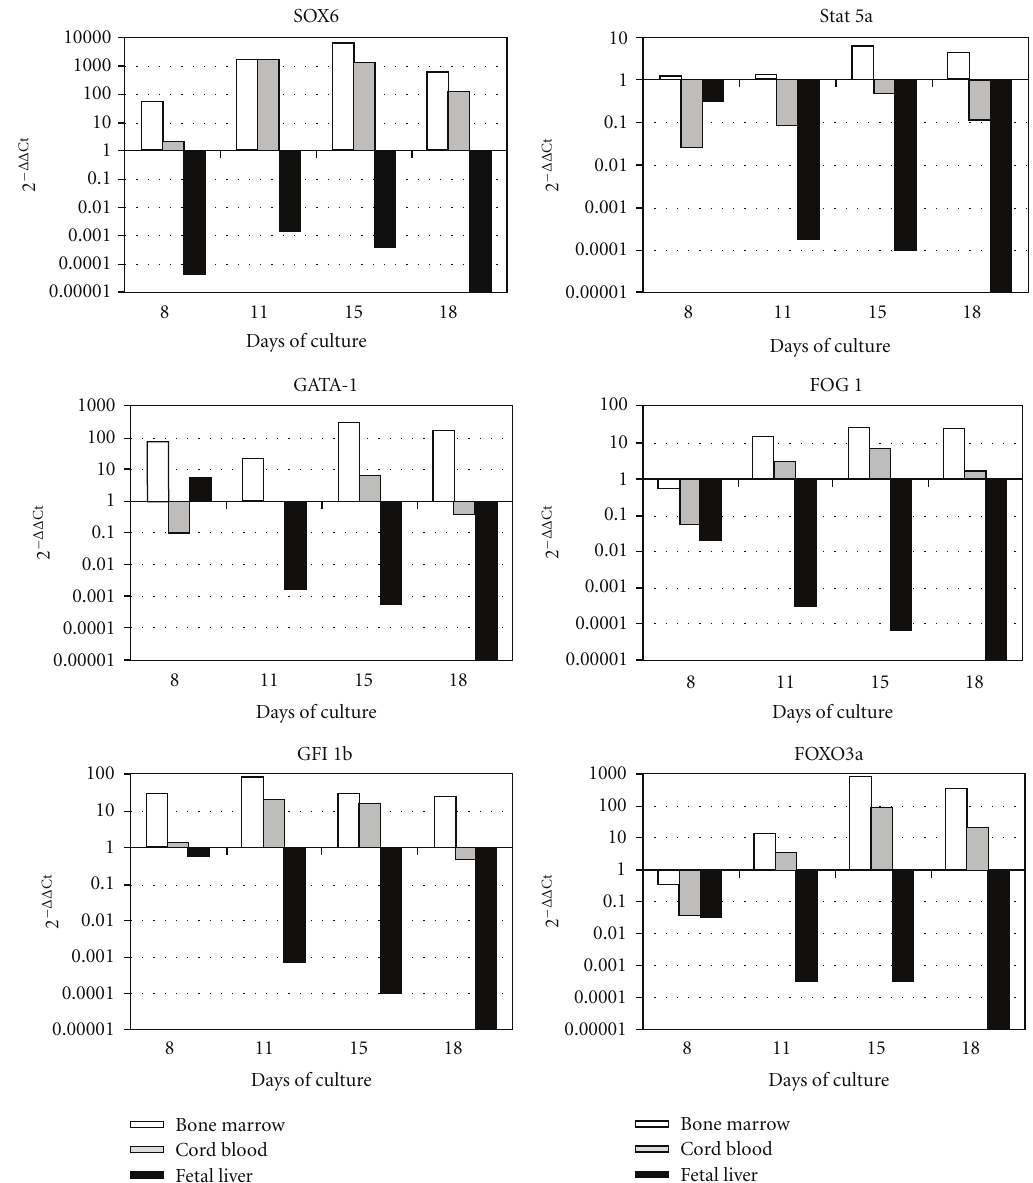
Figure 5: Gene expression of factors involved in definitive erythropoiesis. Quantitative real-time PCR analysis of genes known to be implied in definitive erythropoiesis at di ff erent times of culture (days 8, 11, 15, and 18). Relative gene expression is given by the 2 − ΔΔ Ct method where ΔΔ Ct represents the di ff erence of an unknown sample (days 8, 11, 15, and 18 of culture) versus a control (day 0 of culture) for a target gene normalized to a control gene